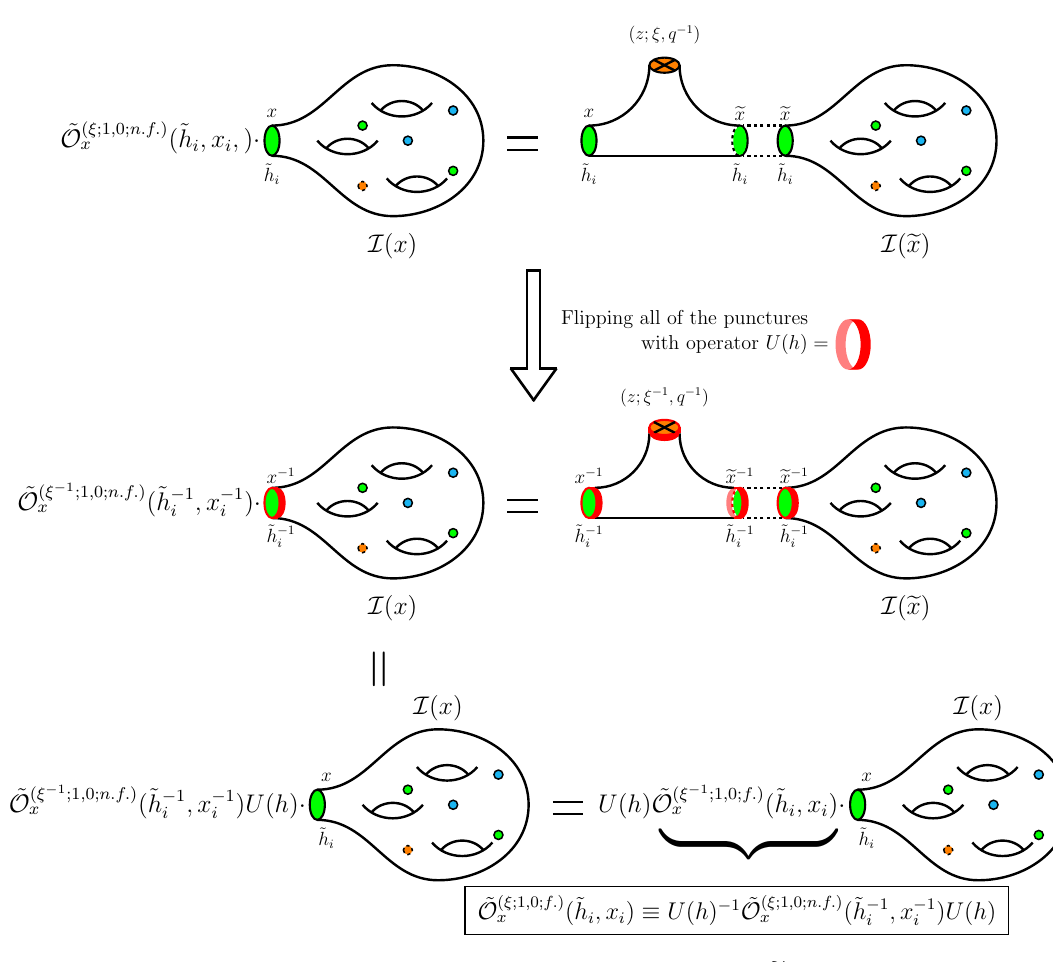
Figure 13: Geometric proof of the relation between flip (cid:101) O ( ξ ;1,0; f . ) and no flip ( ξ ;1,0; n . f . ) operators. In the first line we present the construction of no-flip oper- (cid:101) O ator. Then we proceed with flipping all moment maps of all punctures. Finally in the last line the relation between flip and no flip operators is